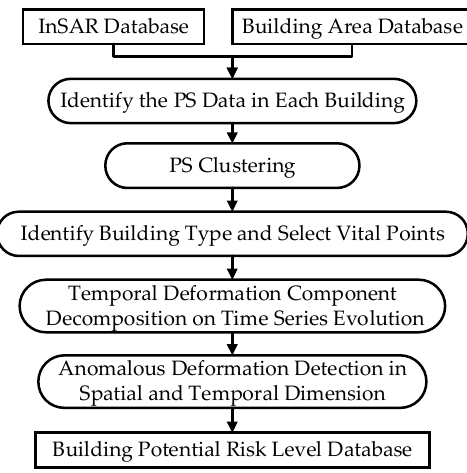
Figure 13. Flowchart of the building risk level process chain.